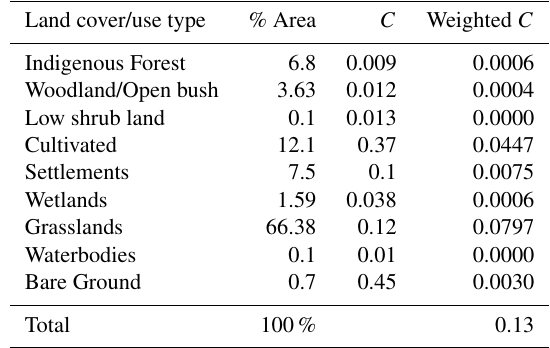
Table 1. Cover factor ( C ) for the Ntabelanga Dam